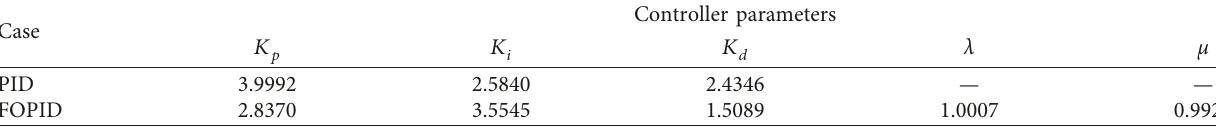
Table 12: The optimized controller parameters with Δ f � + 0 . 5Hz.